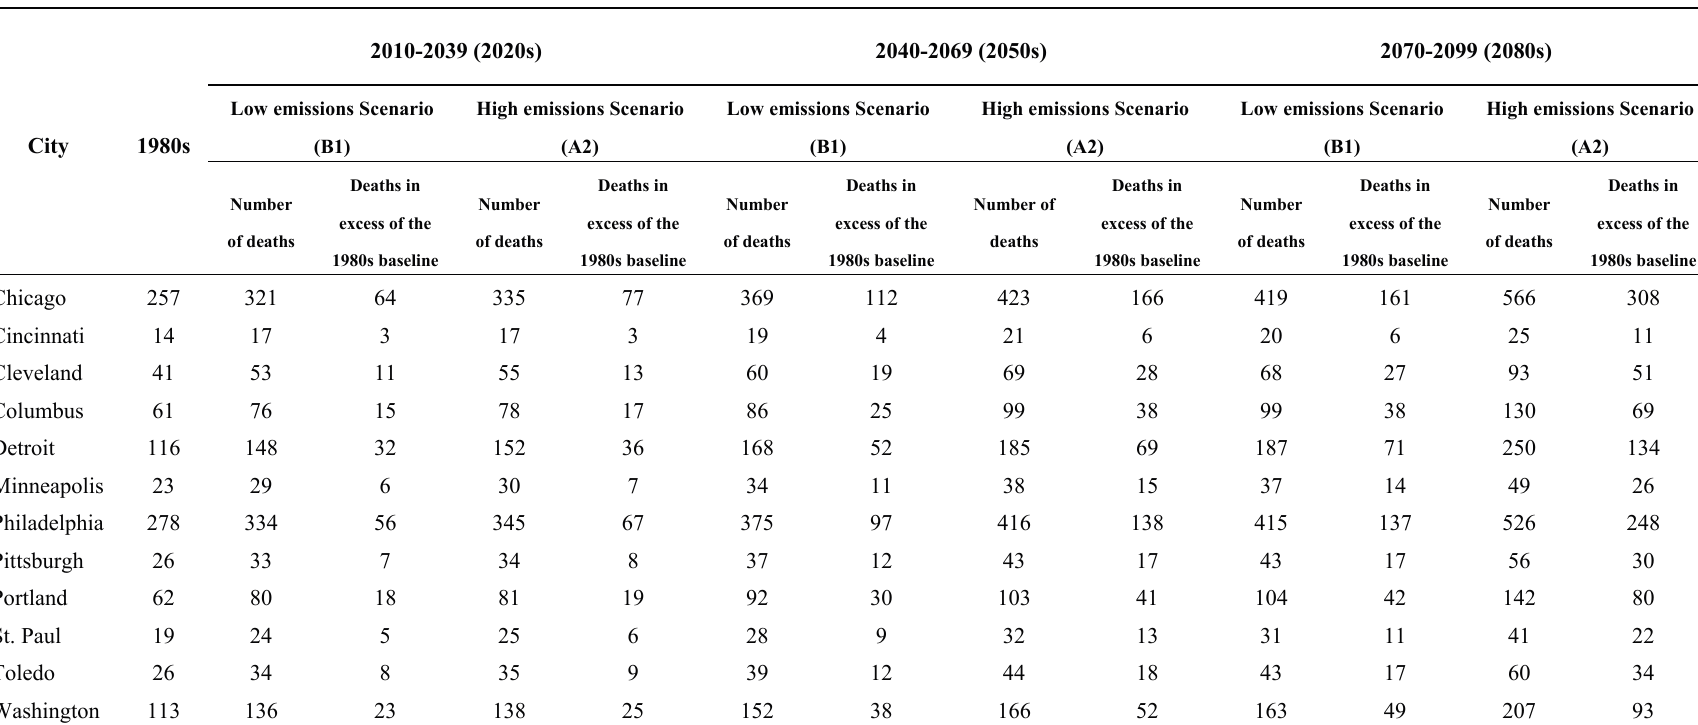
Table 3. Median number of expected heat-related annual deaths in the 2020s, 2050s and 2080s, and excess heat-related premature deaths compared to the 1980s. Median number of expected heat-related annual deaths is calculated across the 16 global climate models (GCMs) and shown separately for the low emissions (B1) and high emissions (A2)